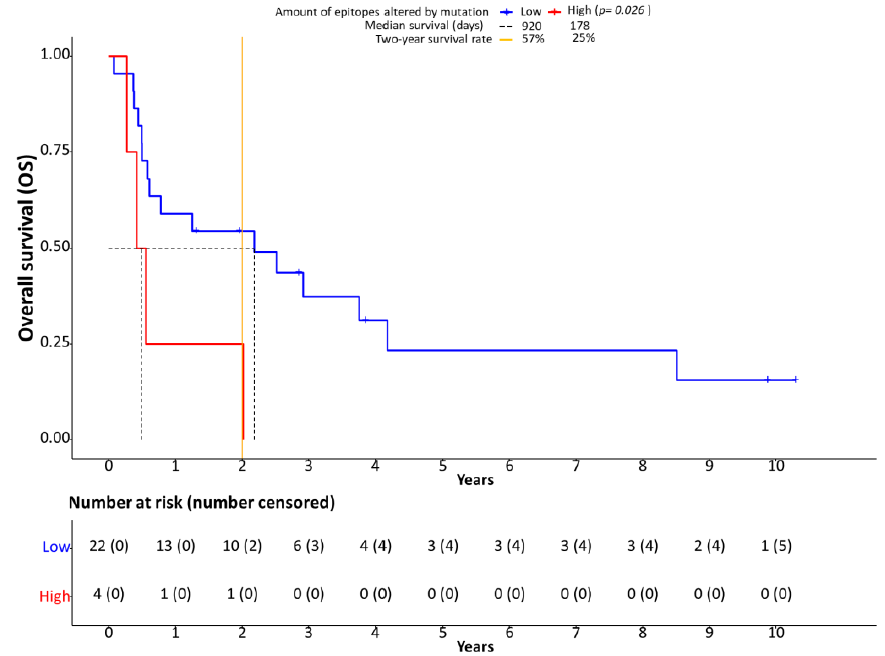
Figure 5. Processing escapes and survival. Kaplan-Meier plots showing overall survival (OS) in relation to the number of epitopes altered by mutation. The cutoff between low and high number of epitopes altered by mutation was set at 20 based on bimodal value